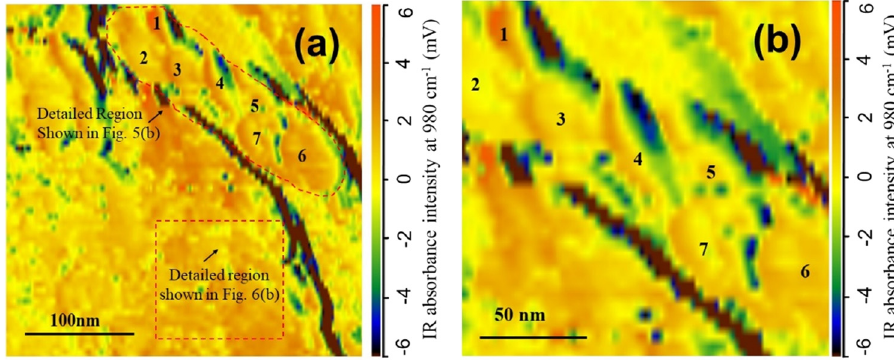
Figure 7: AFM - IR mapping results for the region shown in Figure 3: ( a ) entire region; ( b ) magni fi ed region associated with C – S – H gel particles numbered 1 –